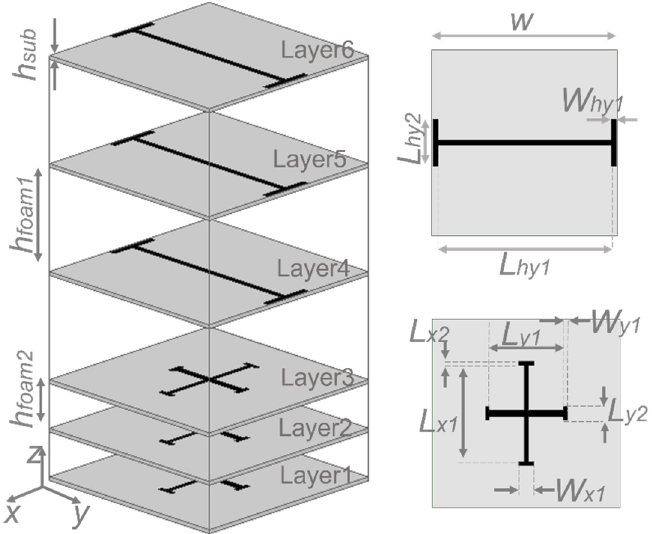
Figure 1. Configuration of the elementary cell.